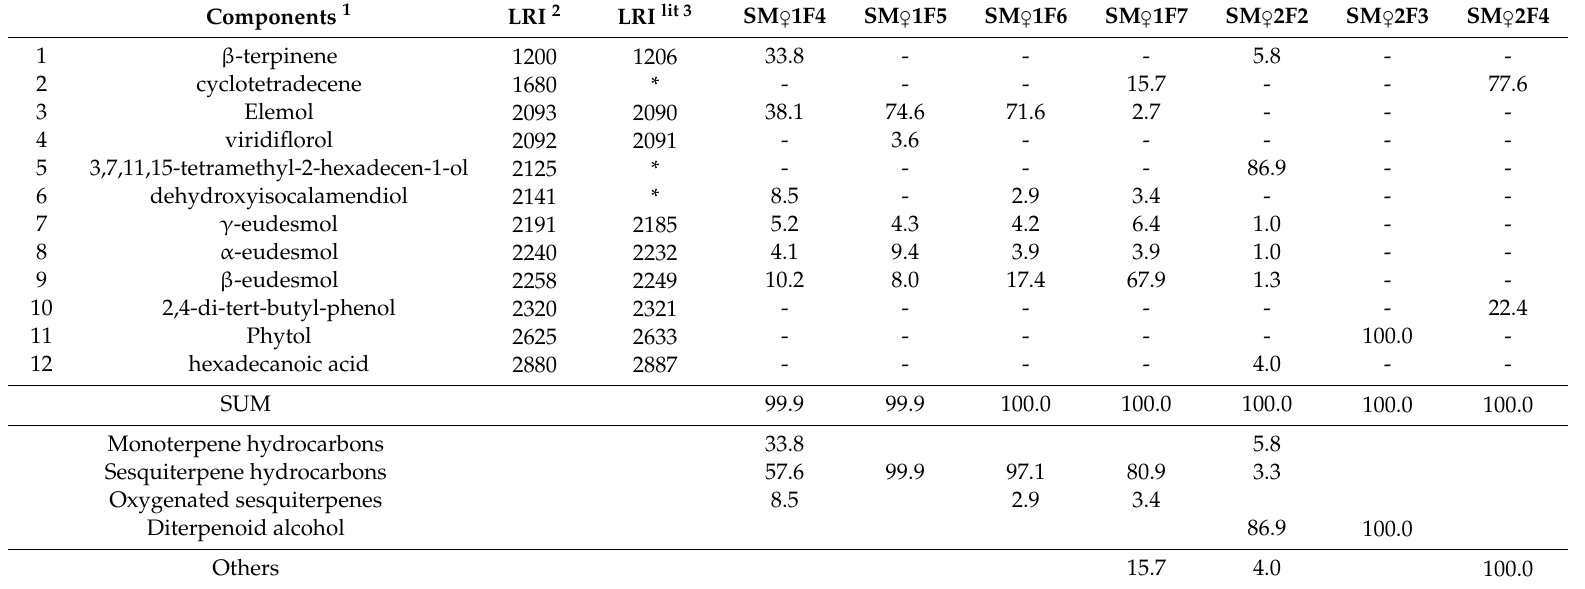
Table 3. Chemical composition (%) of petroleum ether and diethyl ether fractions from female S. molle (L.) leaves.